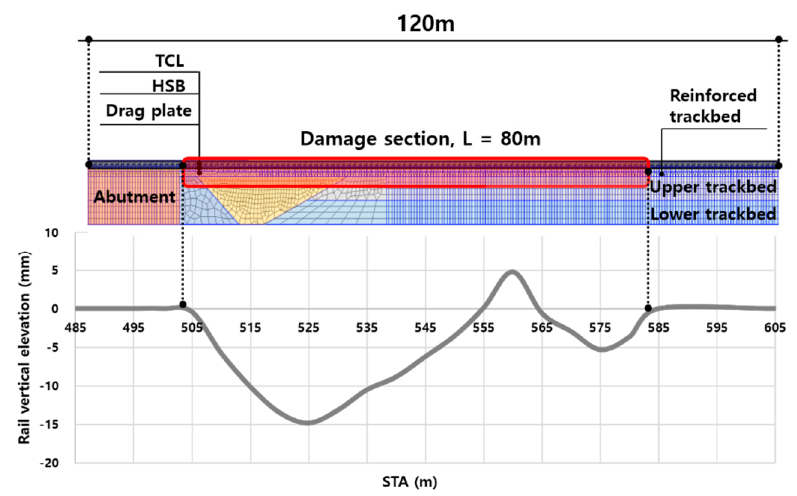
Figure 16. Modeling of transition section considering site conditions.